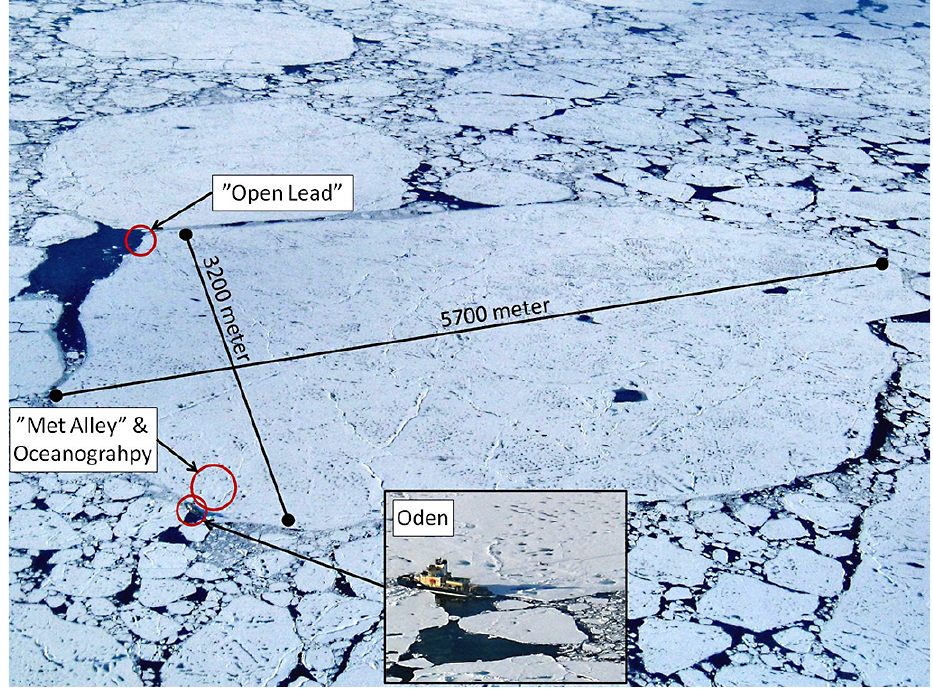
Fig. 4. Aerial photograph from 26 August of the ice floe used for the ice drift, from 12 August through 1 September. The ice floe was approx- imately 3km by 6km in size; Oden can be seen in the lower left corner of the floe. Most of the boundary-layer and physical oceanography measurements were taken in the vicinity of the ship. At this location the ice was 2–8m thick, and a local ∼ 120 ◦ corner in the floe allowed mooring of the ship in four main directions. The marine biology and chemistry site, also with aerosol flux observations, was located some ∼ 3km away from the ship in the upper left corner in the